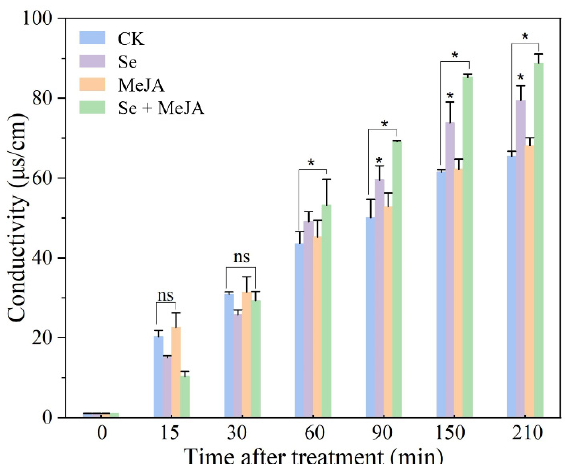
Figure 3. Effect of Se, MeJA and Se + MeJA on mycelium conductivity (n = 4). CK: Control group; Se: 5.0 mg/L Se; MeJA: 0.4 mM MeJA; Se + MeJA: 5.0 mg/L Se with 0.4 mM MeJA. Data are mean values, and error bars represent SE among four replicates. Values with “ns” are not significantly different and “*” indicates that there is significant difference between the two groups at p < 0.05 according to Duncan’s multiple range test.